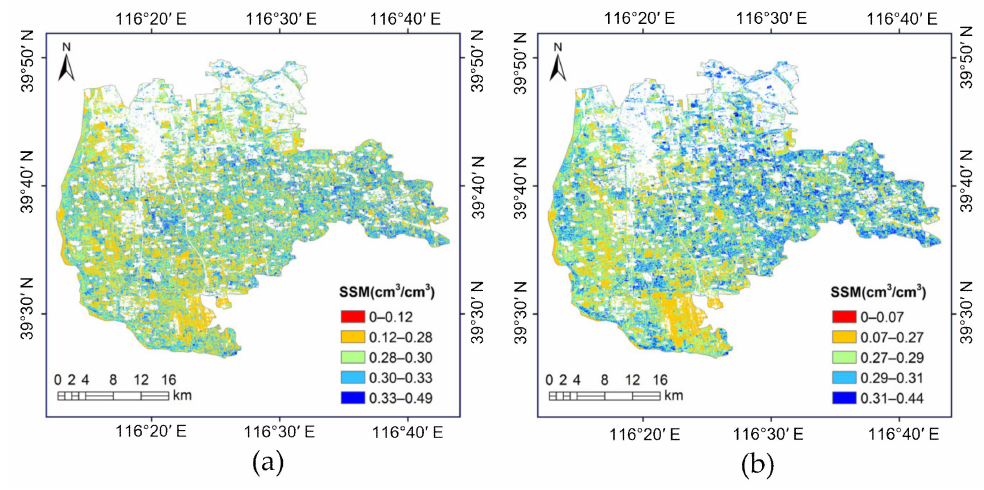
Figure 7. SSM mapping on two different dates: 28 April 2019 ( a ), and 29 April 2021 ( b ), in Daxing, Beijing, China.